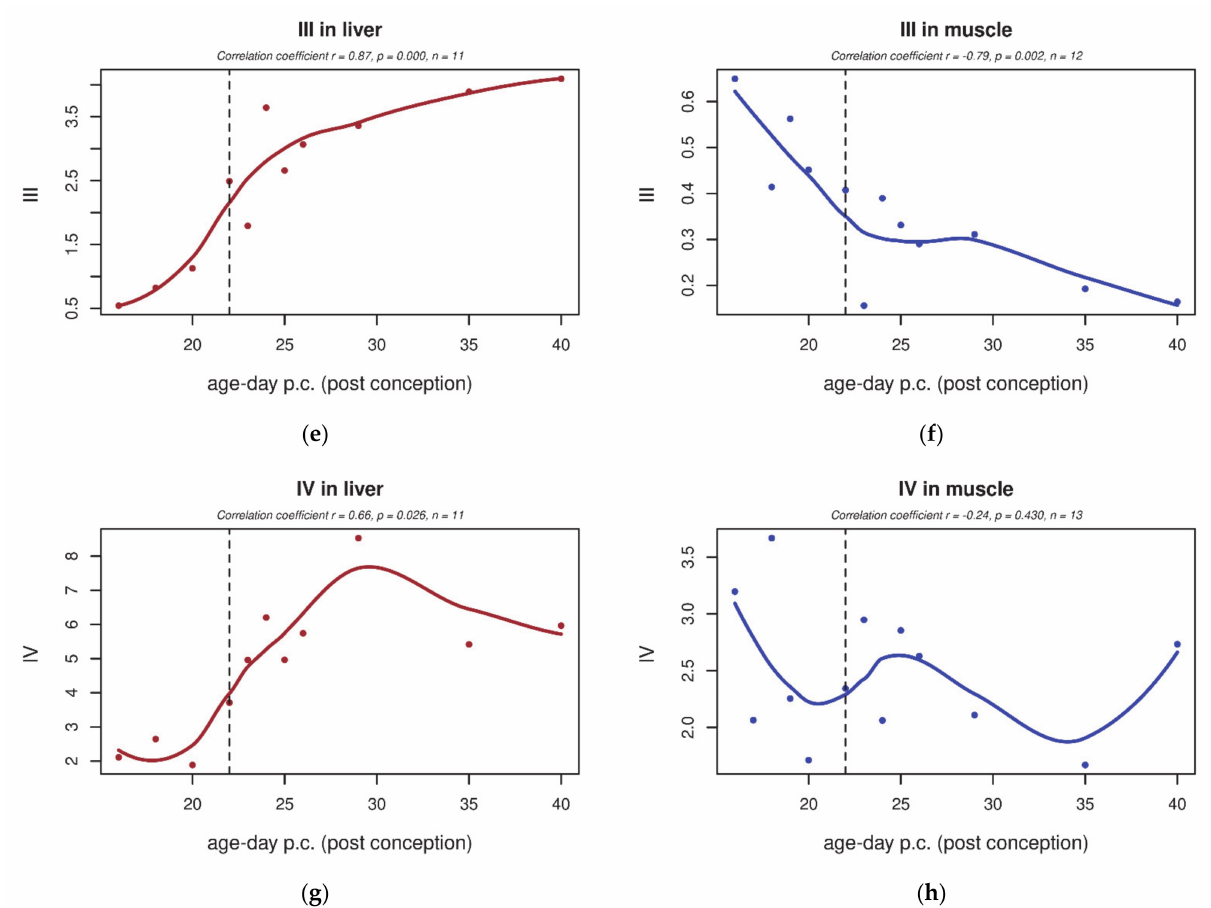
Figure 3. Tissue-specific changes in electron transport chain (ETC) complexes’ activities in rat liver and skeletal muscle during early development. ( a , c , e ) In the liver, enzyme activities of ETC complexes significantly increased after birth. ( b , d , f ) In skeletal muscle, only the activities of complexes I ( b ) and III ( f ) changed, decreasing significantly after birth ( p ≤ 0.05). ( g ) In the liver, complex IV activity significantly increased after birth ( p ≤ 0.05). ( h ) In skeletal muscle, complex IV activity did not significantly change after birth. Enzyme activities normalised to citrate synthase are shown. The dashed line indicates the last foetal day/birth. I—NADH:coenzyme Q 10 oxidoreductase, II—succinate:coenzyme Q 10 oxidoreductase, III—Coenzyme